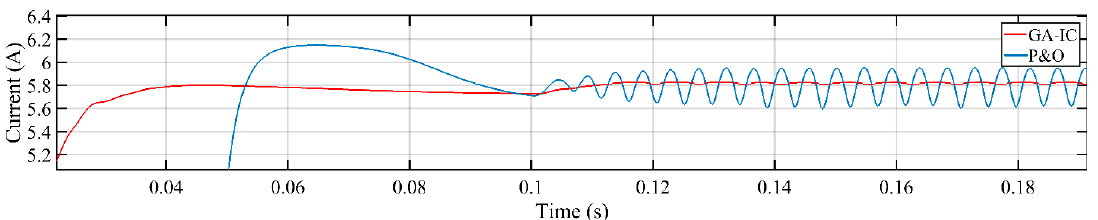
Figure 36. Case 3 current comparison of modified GA-IC vs. P&O.